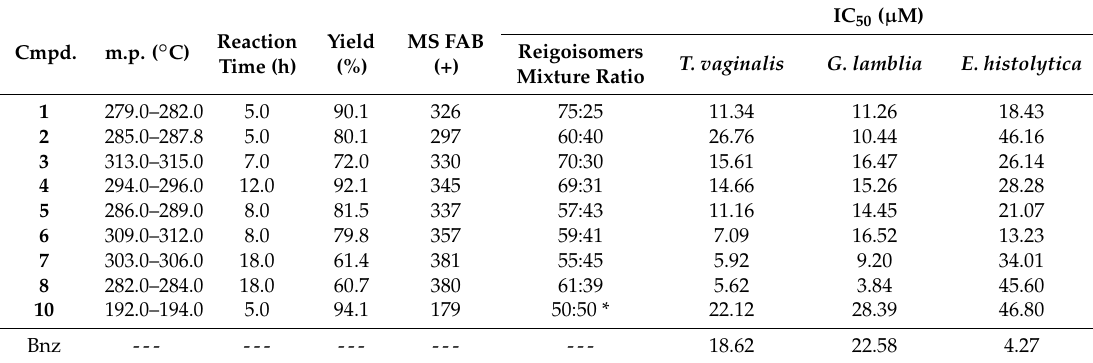
Table 2. Physicochemical properties, and in vitro antiprotozoal bioactivity benznidazole analogues 1 – 8 .